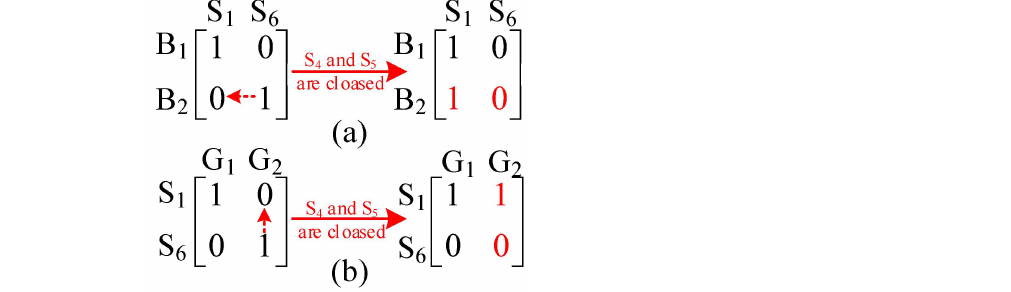
Figure 5. Correlation matrix adjustment process. ( a ) Input correlation matrix adjustment process. ( b ) Output correlation matrix adjustment process.